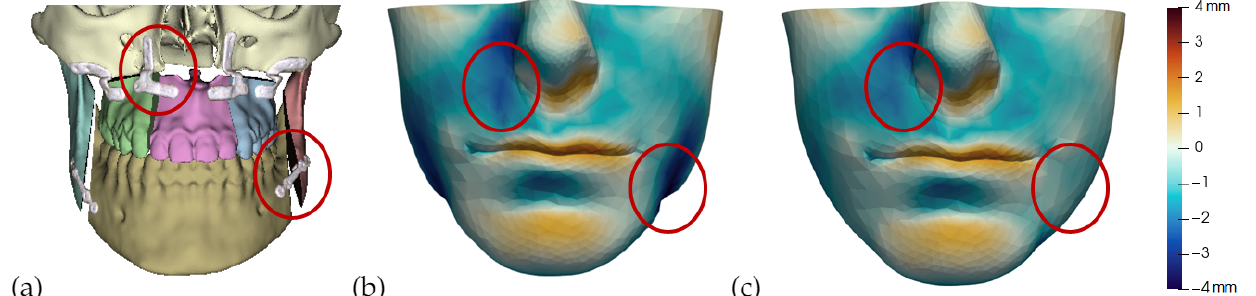
Figure 2. This figure shows the impact of the smooth coupling method described in Section 2.3.3 on the planning simulation for patient M2. ( a ) shows, color-coded, the different cuts applied to the maxilla and the mandible. It also shows implants added in the real surgery, with two of them highlighted with red ellipses. The next two images compare the planning simulation without smooth coupling ( b ) and with smooth coupling ( c ). With smooth coupling, the error is notably lower near the cuts, as shown for example in the two highlighted areas. Notice how the smooth coupling method even approximates the insertion of implants in a very easy yet accurate